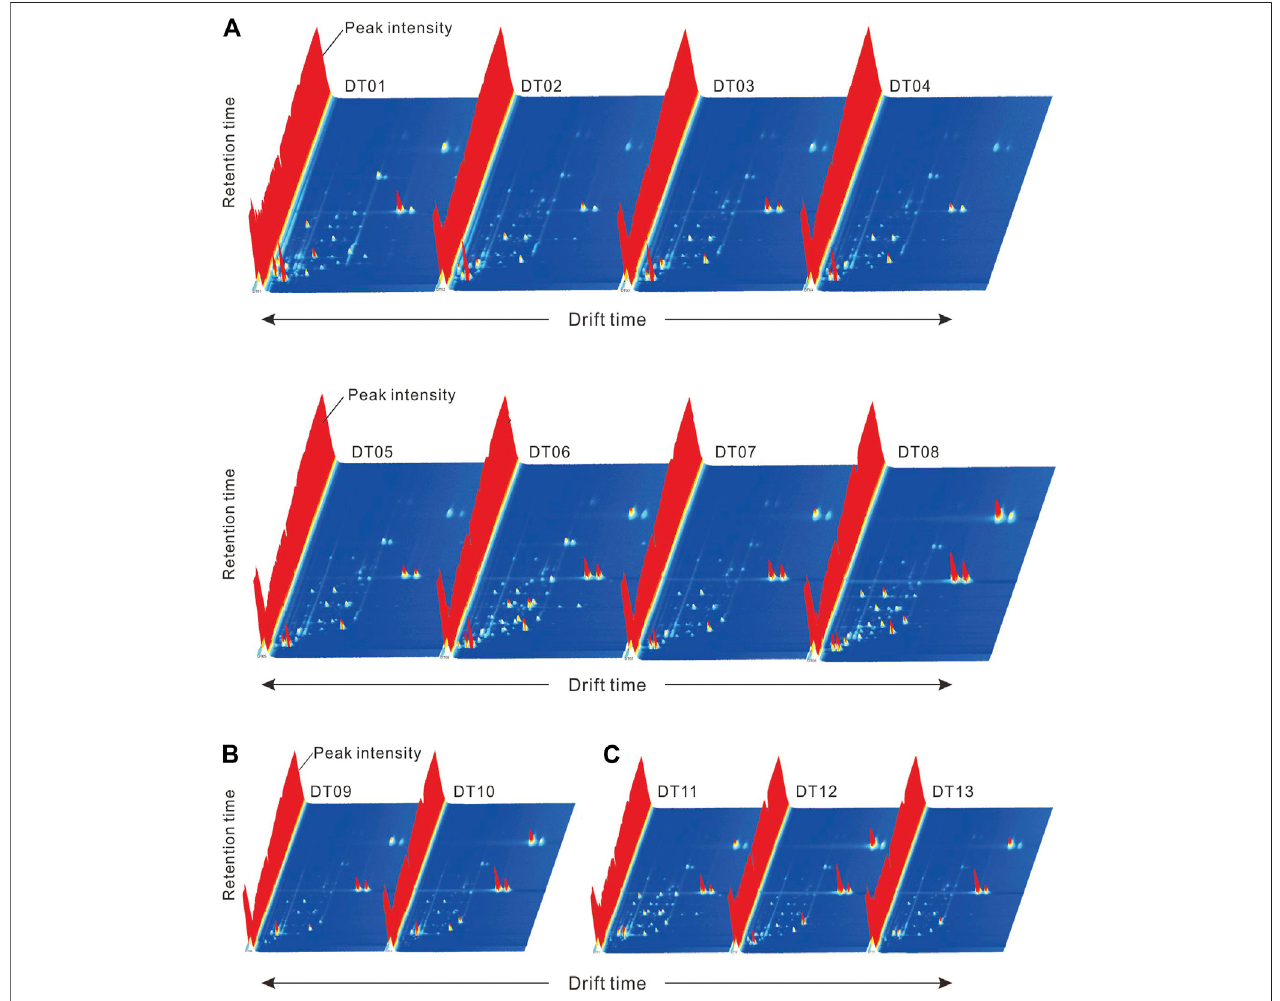
FIGURE 2 | Three-dimensional topographical plots of GC-IMS for different samples: (A) : clay (DT01 – DT08); (B) : sandstone (DT09 – DT10); and (C) : halite (DT11 – DT13).